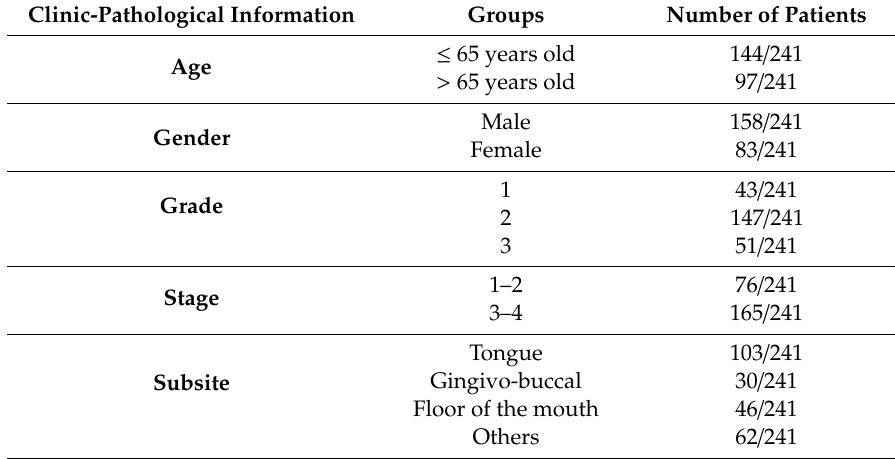
Table 1. Clinical-pathological characteristics of patients included in The Cancer Genome Atlas (TCGA) analysis.